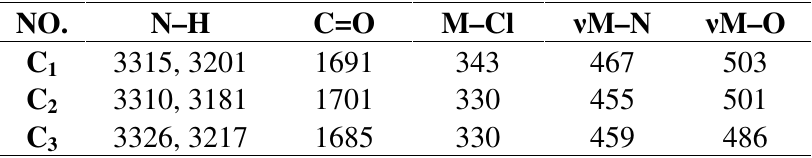
Table 3. FT-IR (cm −1 ) bands of metal complexes.